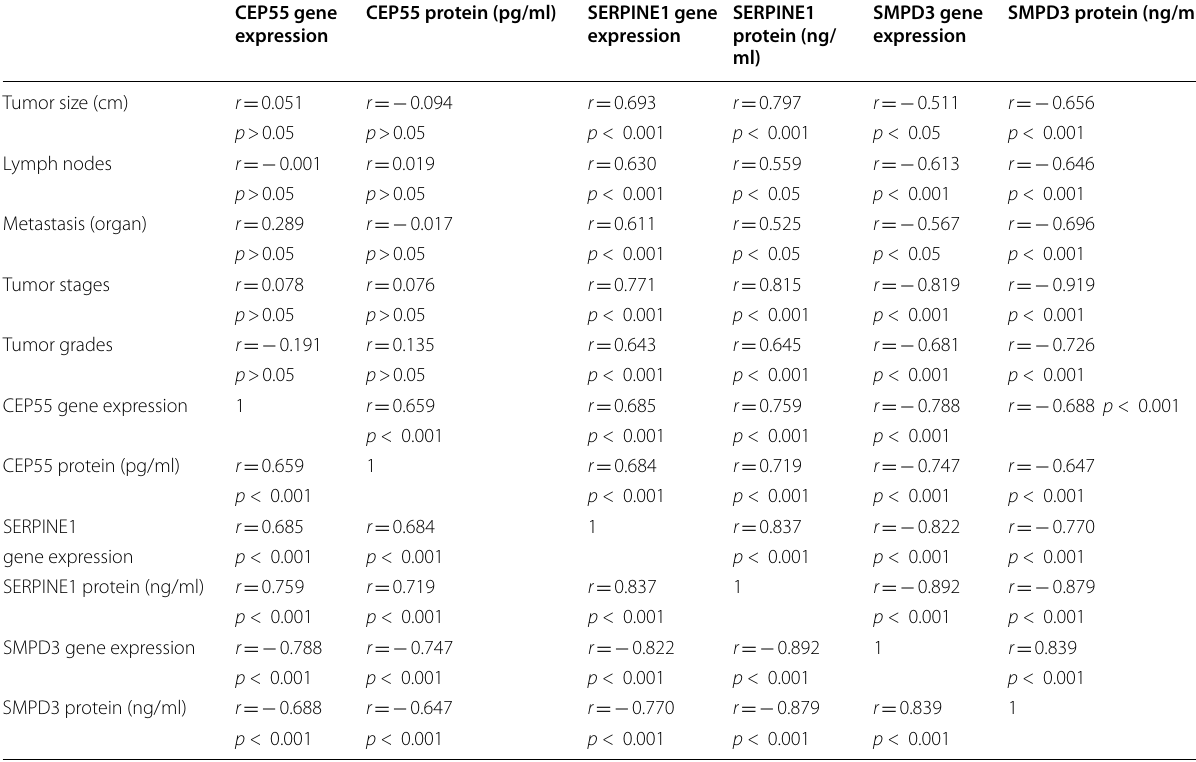
Table 3 Correlations of the studied parameters in the studied